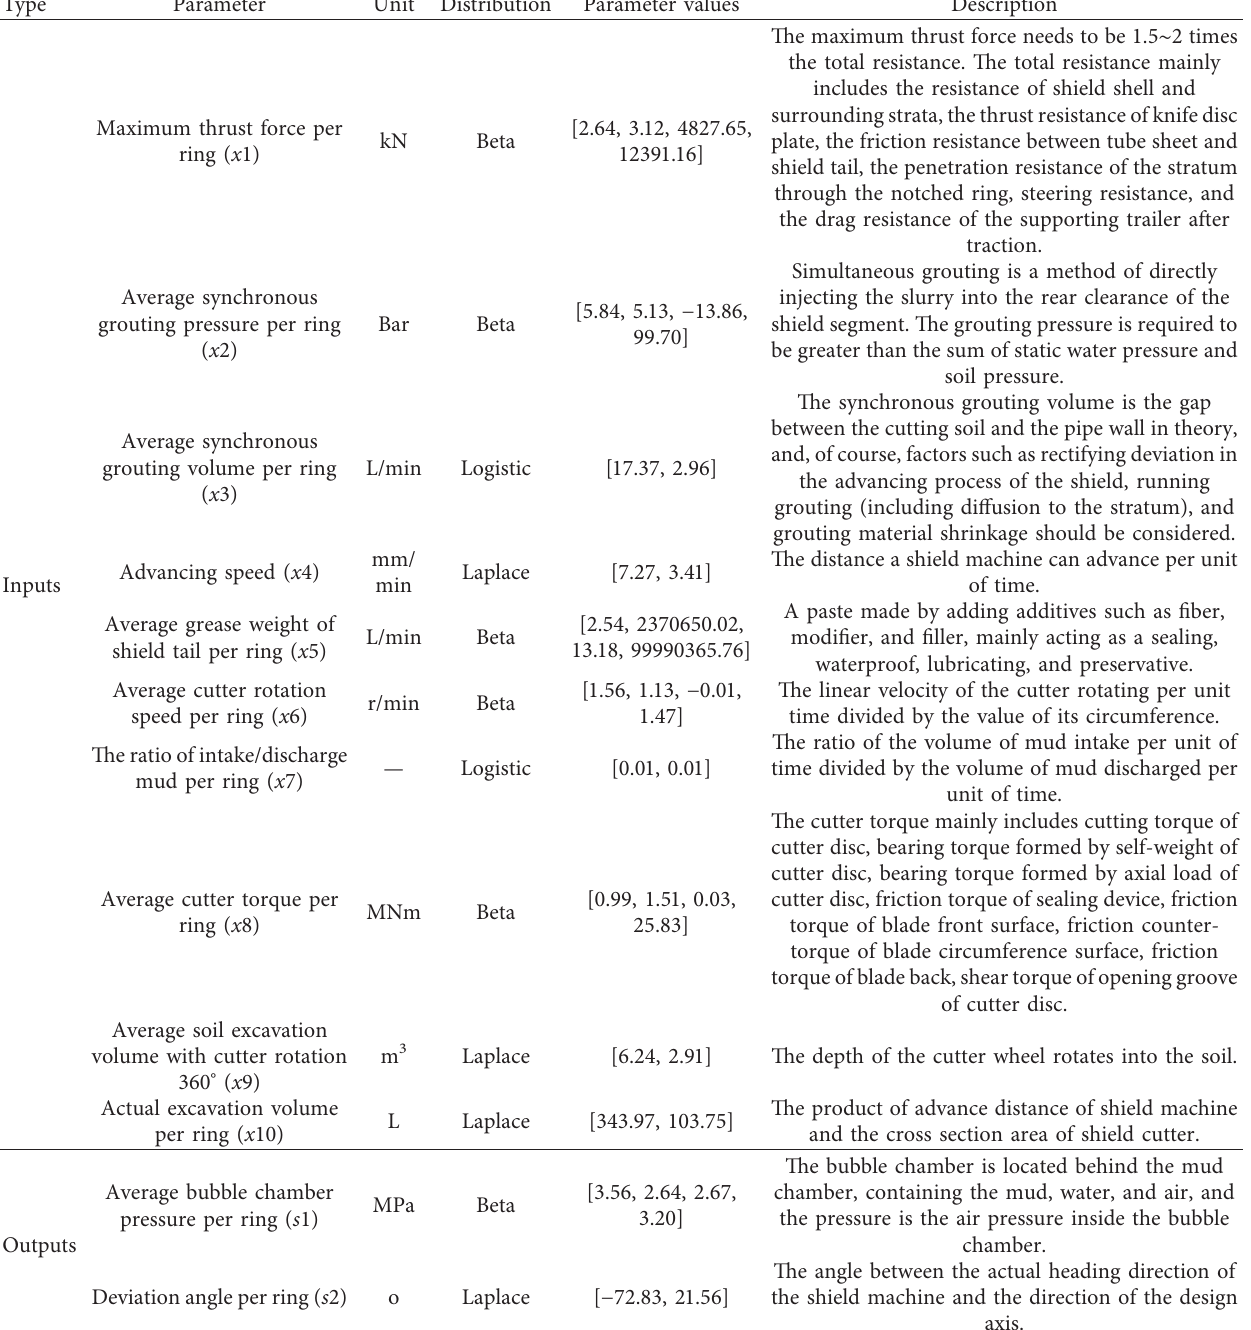
Table 1: The significant parameters on the BIM-BDP for UA/SA